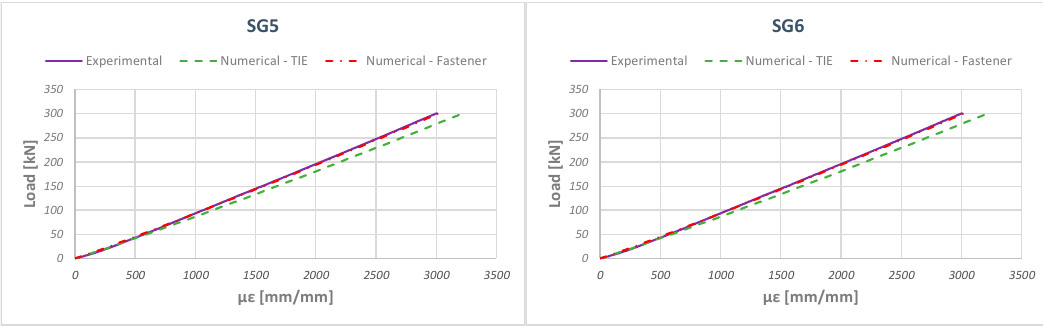
Figure 15. Numerical–experimental comparisons for SG-7 and SG-8: numerical TIE and Fasteners models.